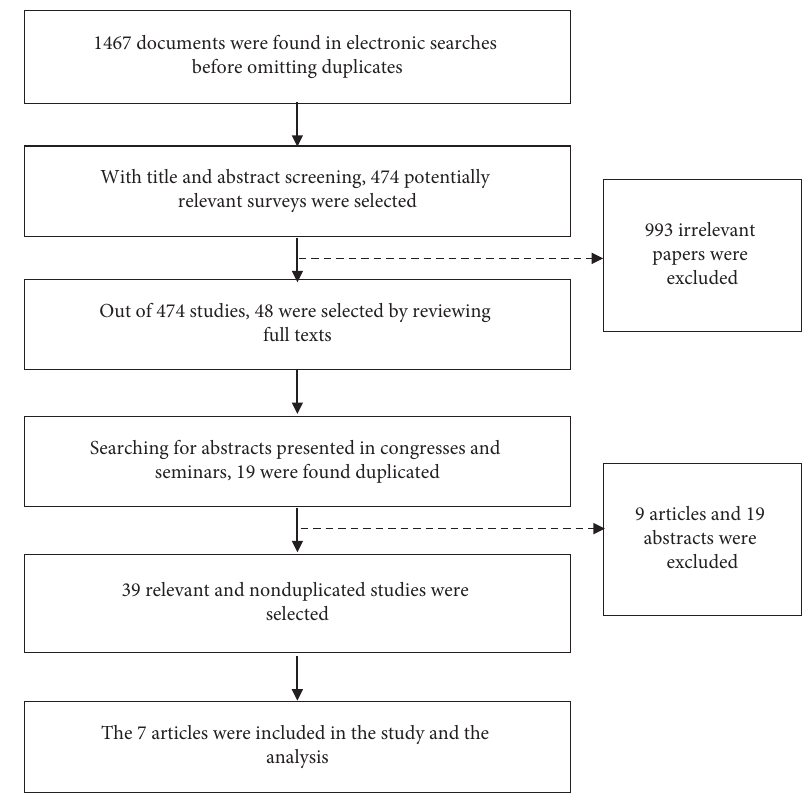
Figure 1: Follow diagram of systematic review and searches for effect of genetically modified food on infertility